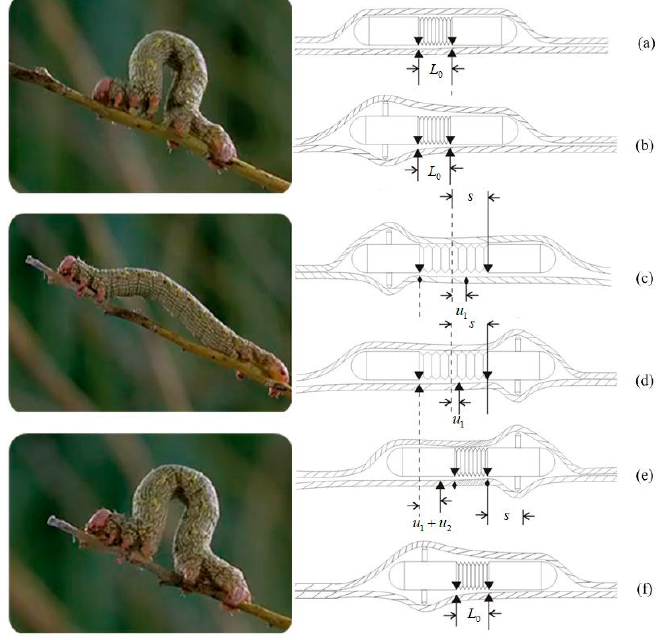
Figure 1. Locomotion principle of the IIMR.